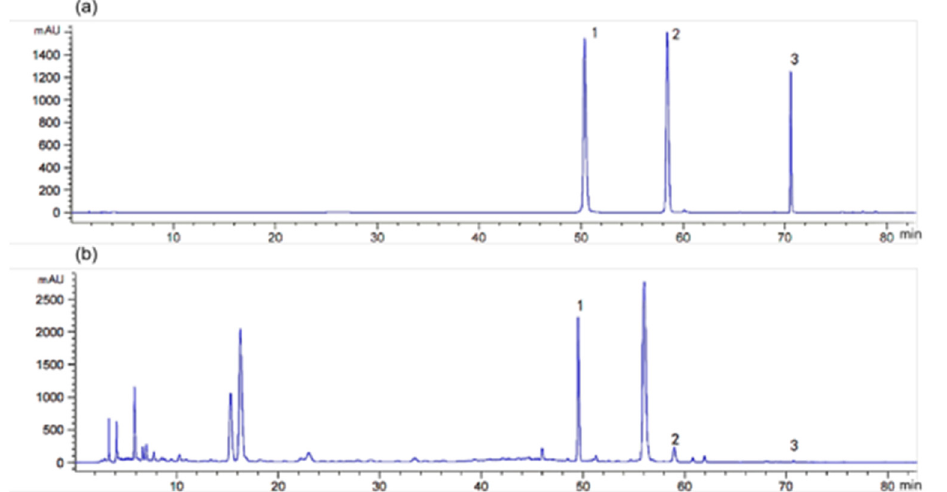
Figure 3. Determination of flavonoids (luteolin, apigenin, acacetin) in standard and sample by HPLC: ( a ) HPLC of standards; ( b ) HPLC of the samples. 1 represents luteolin, 2 represents apigenin, 3 represents acacetin. (Table S1)